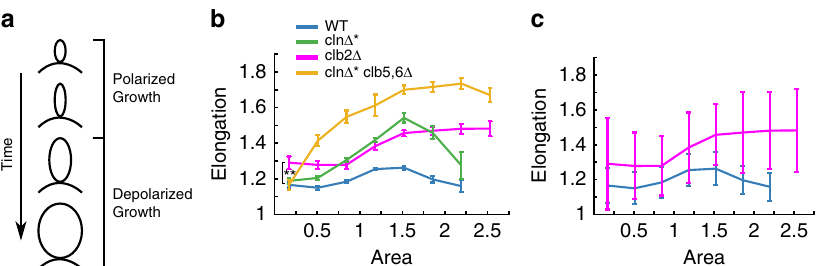
Fig. 8 Clb2 promotes a more circular cell shape beginning early in the cell cycle. a Schematic of cell shape during growth. b Mean and SEM of elongation versus area for different cyclin mutants. **: p = 0.004, single-tail t-test. c Mean and STD for two of the populations from panel b illustrating the variability in the data. b , c Abscissa scaled so that 1 is the mean area of wild-type cells, corresponding to 16.3 μ m 2 . n = 525 (WT), 500 ( cln Δ * ), 597 ( clb2 Δ ), 543 ( cln Δ * clb5,6 Δ ). The largest 2.5% of the overall population was discarded. The remaining range was binned into 8 equal intervals. There were no WT or cln Δ * cells in the largest bin, therefore, no values are